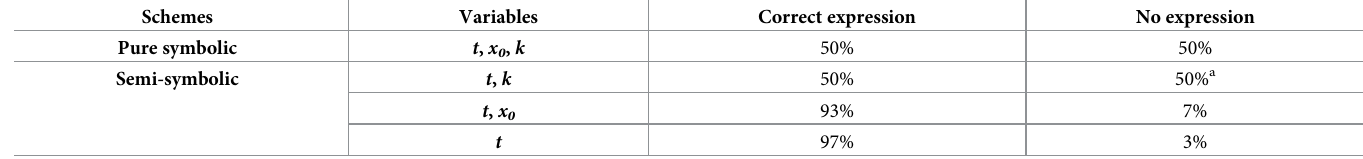
Table 5. Performance of BioSANS in generating analytical expression for species concentration with different symbolic computation modes.